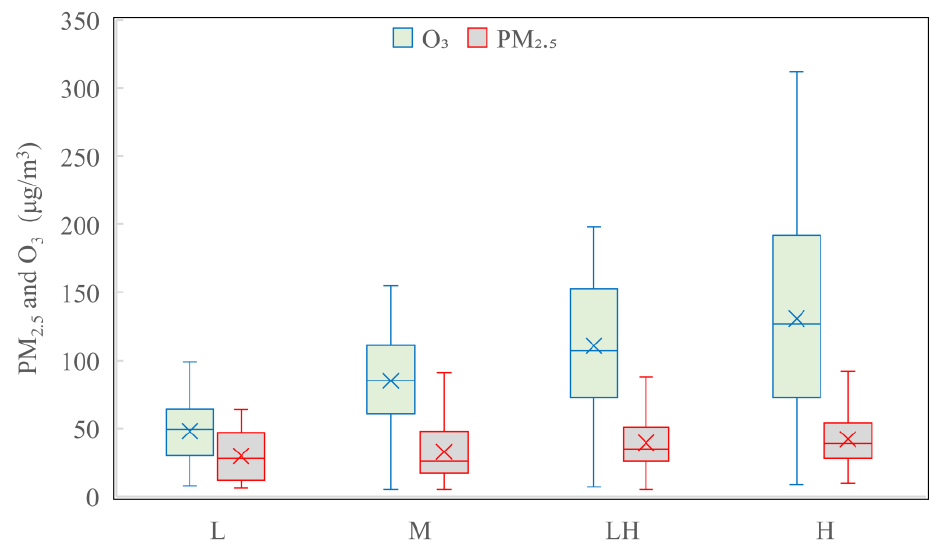
Figure 2. Box plots of PM 2.5 and O 3 mass concentrations under different photochemical activity levels during summertime 2020 in Tianjin, China. Box represents 25–75th percentiles, whiskers represent the minimum and maximum values except outliers, and horizontal lines in the middle of the boxes represent the median values.